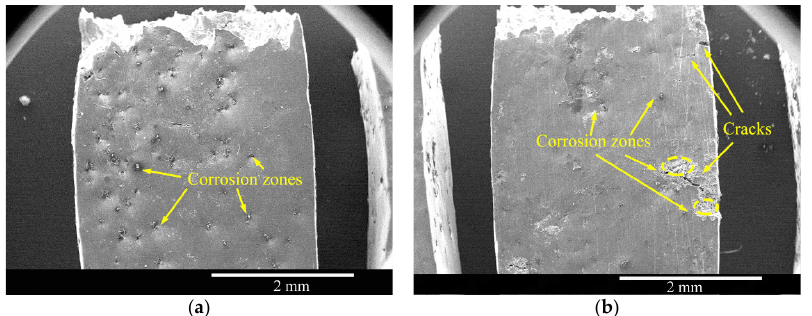
Figure 9. Top-surface morphologies of the ( a ) as-cast and ( b ) solid-solution-treated AM50 magne- sium alloy samples SSRT tested after pre-immersion in 3.5% NaCl solution for 24 h.